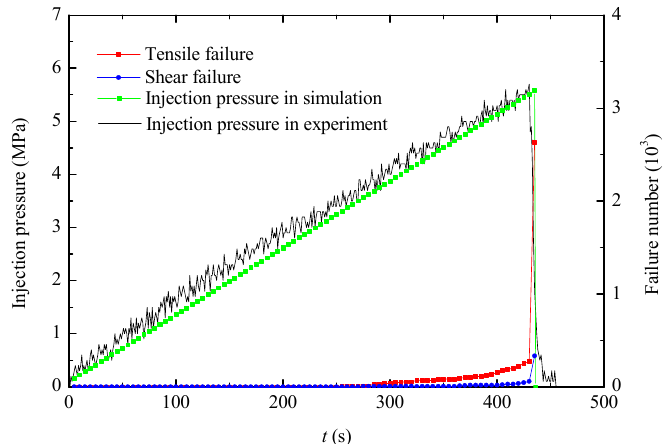
Figure 9. Injection pressure and failure number in numerical simulation.